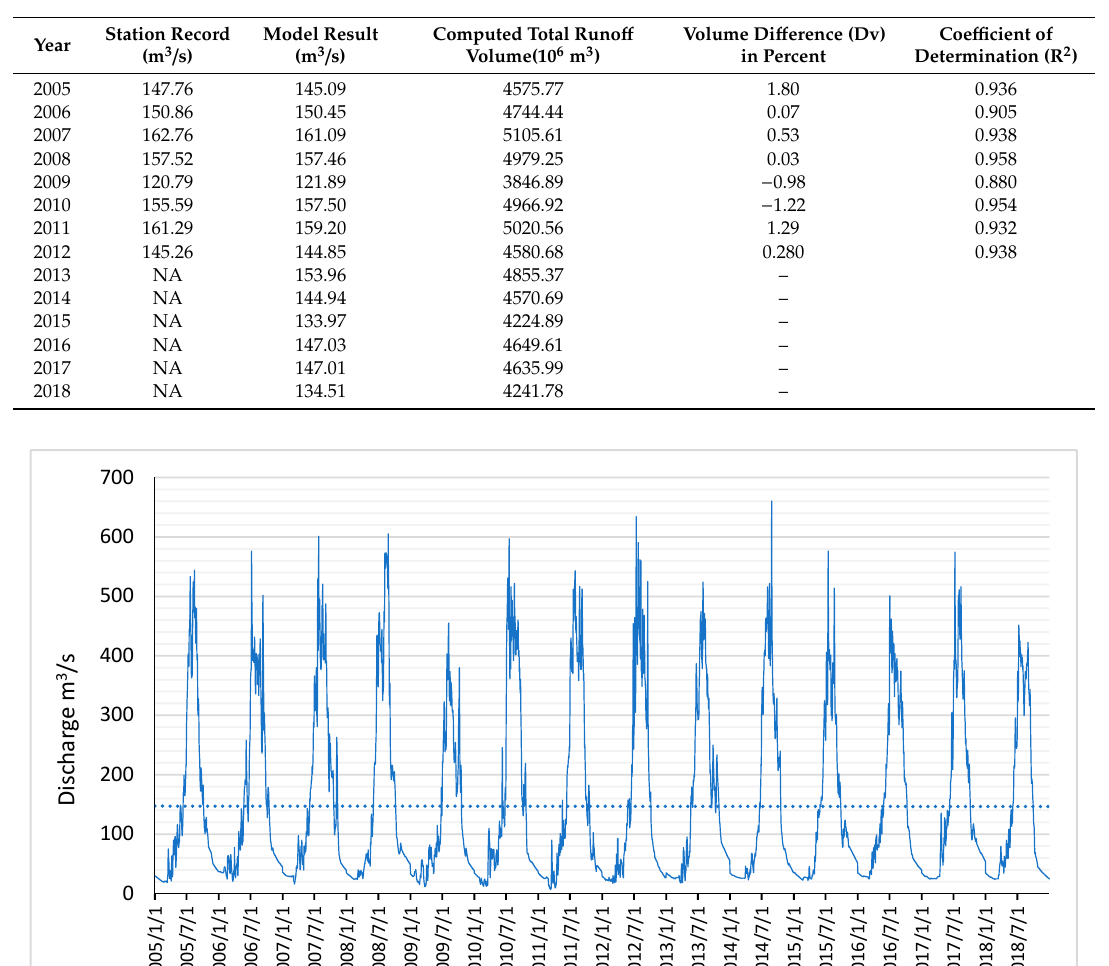
Table 2. Comparison of the Model Result and Station Measured River Discharge.